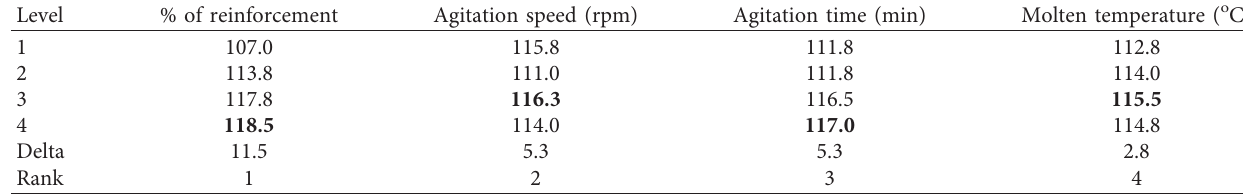
Table 8: Response table for means (Vickers hardness test).